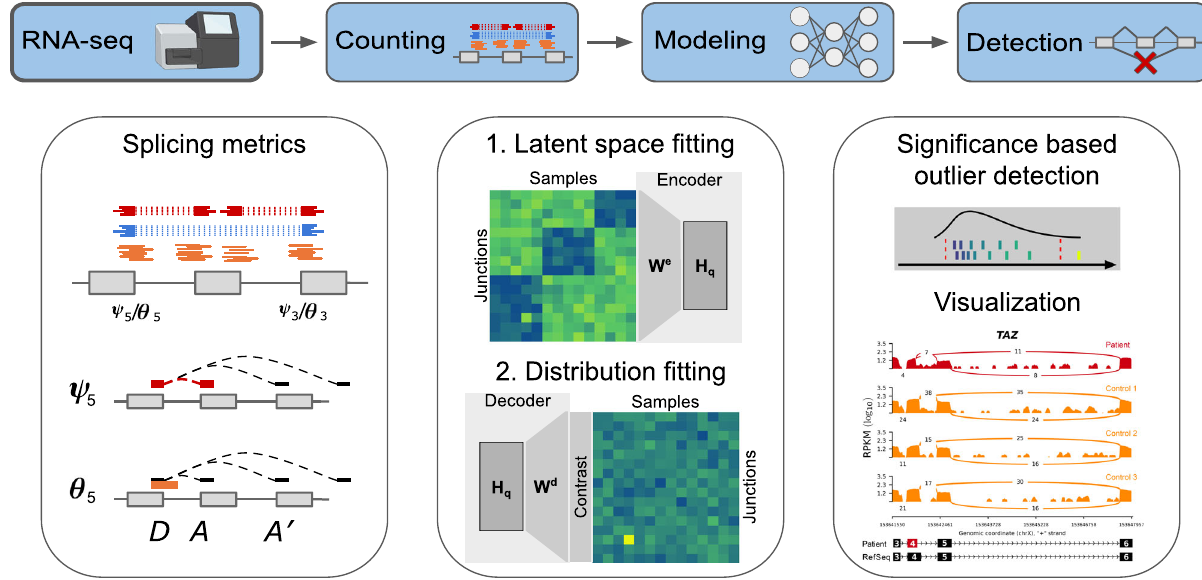
Fig. 1 The FRASER aberrant splicing detection work fl ow. The work fl ow starts with RNA-seq aligned reads and performs splicing outlier detection in three steps. First (left column), a splice site map is generated in an annotation-free fashion based on RNA-seq split reads. Split reads supporting exon – exon junctions as well as non-split reads overlapping splice sites are counted. Splicing metrics that quantify alternative acceptors ( ψ 5 ), alternative donors ( ψ 3 ), and splicing ef fi ciencies at donors ( θ 5 ) and acceptors ( θ 3 ) are then computed. Second (middle column), a statistical model is fi tted for each splicing metric that controls for sample covariations and overdispersed count ratios. Third (right column), outliers are detected as data points that deviate signi fi cantly from the fi tted model. Candidates are then visualized using a genome browser. D donor site, A acceptor site. Made in © BioRender -